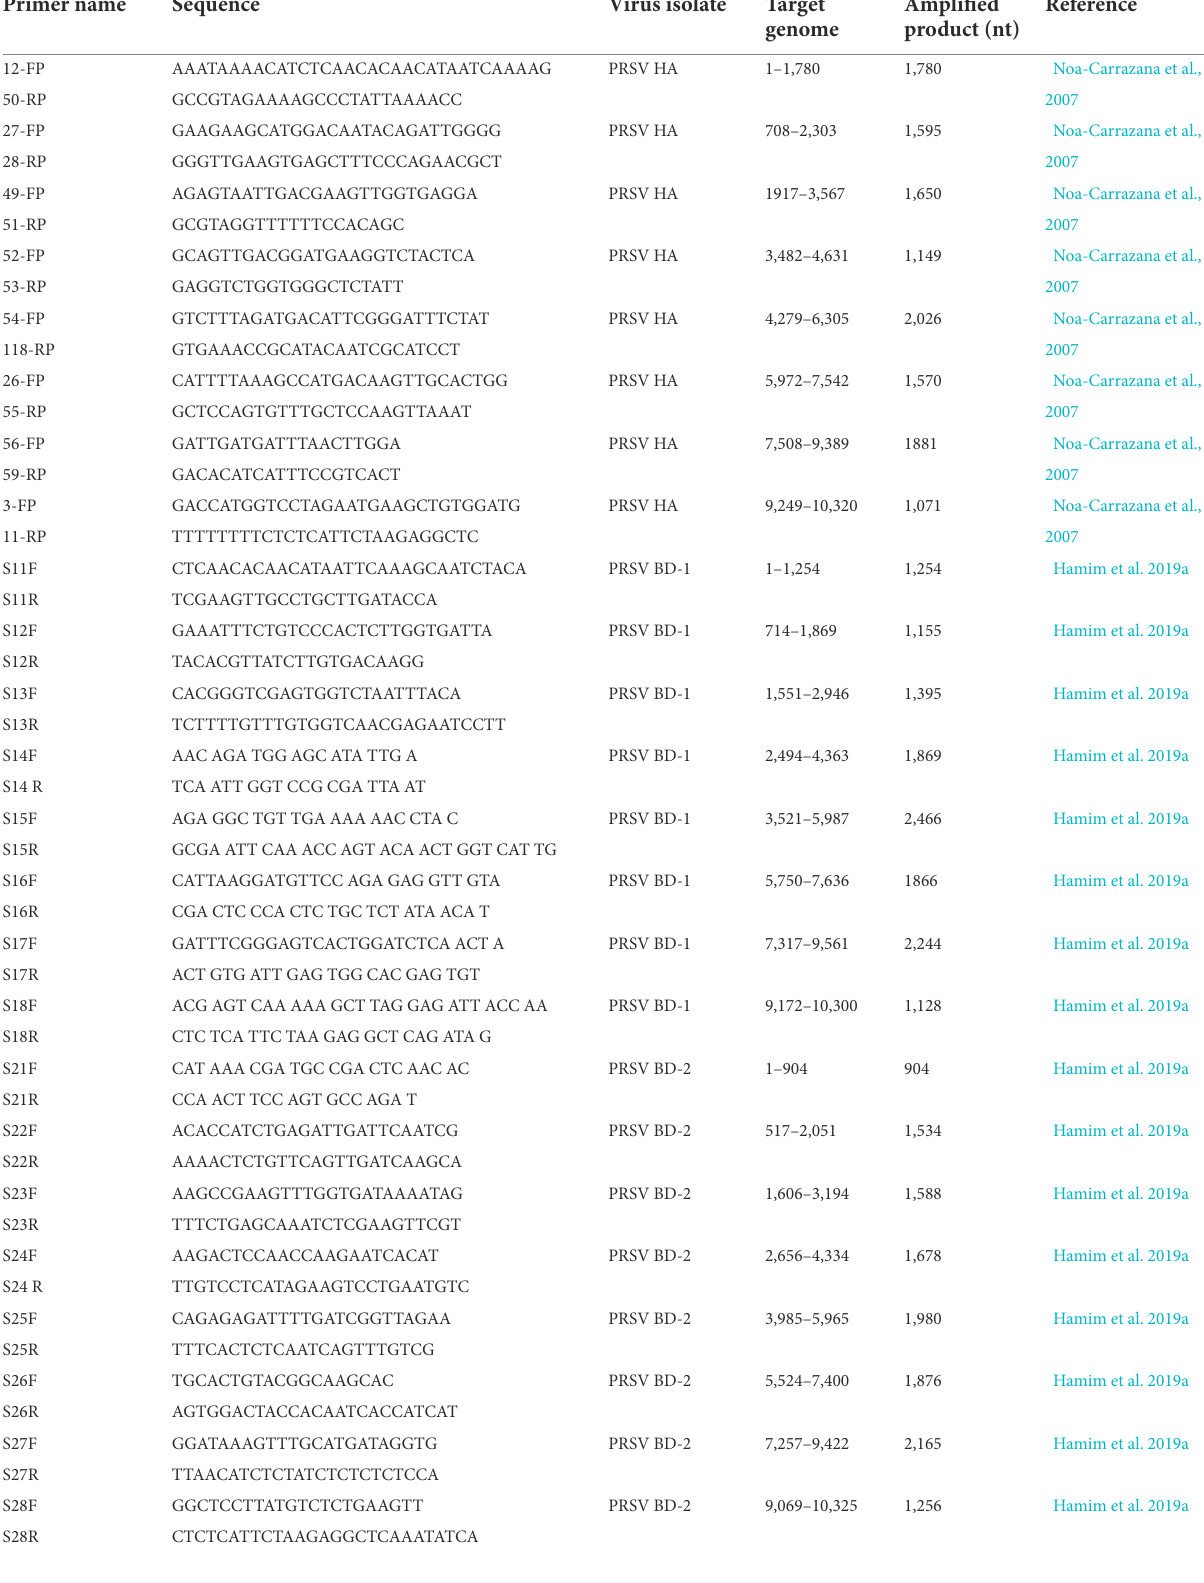
TABLE 1 Primer pairs used in this study for detection and genome characterization of plant viruses from leaf samples stored in RNA later ®